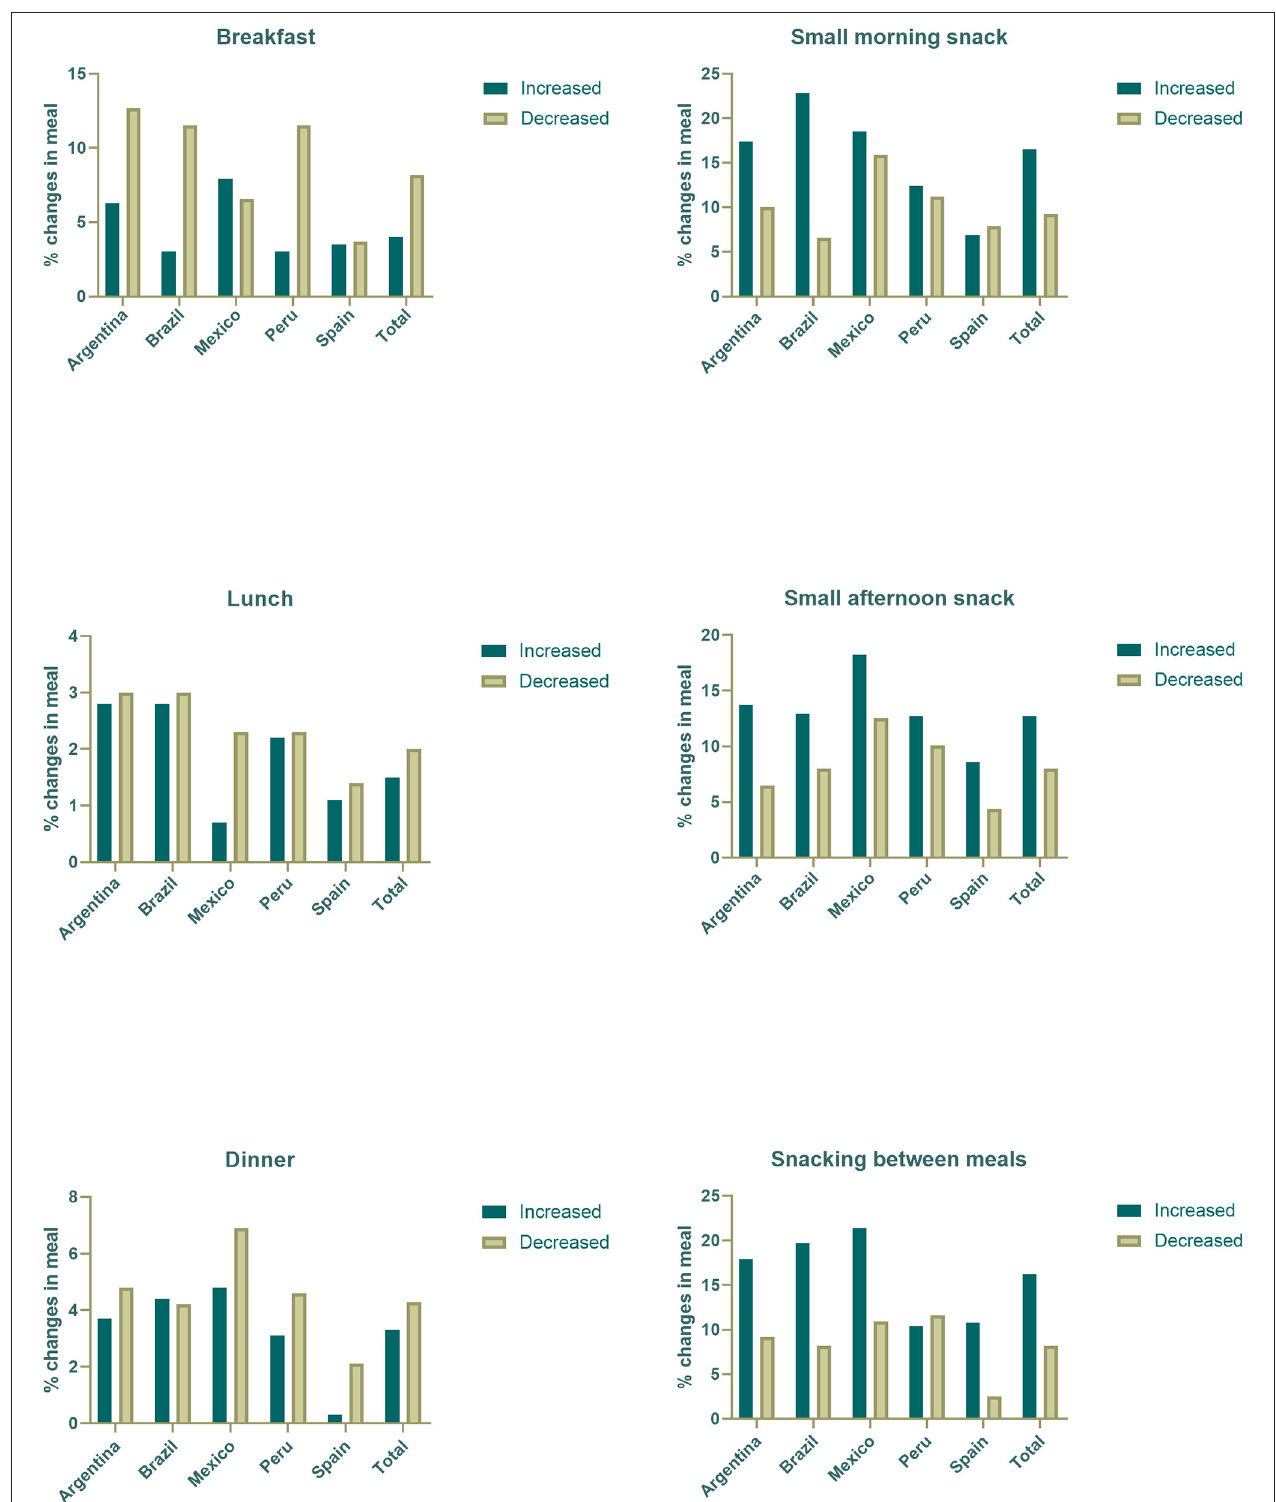
FIGURE 1 | Percentages of change in meal in Iberoamerican countries.